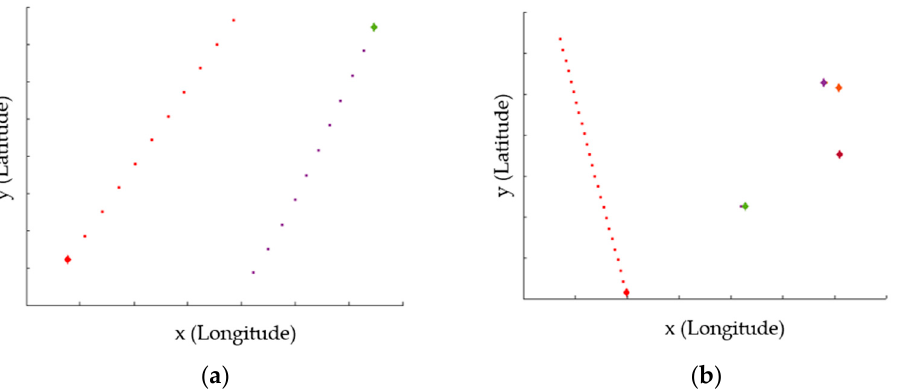
Figure 11. Example of different frequencies in similar navigation situations: ( a ) trajectory example of cluster 7, ( b ) trajectory example of cluster 9.